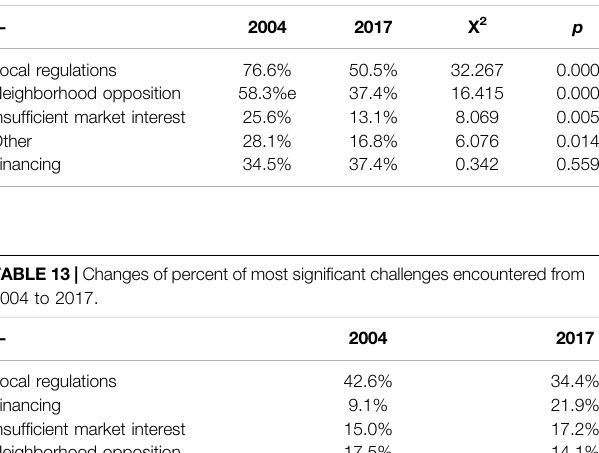
TABLE 12 | Changes of percent of challenges encountered from 2004 to